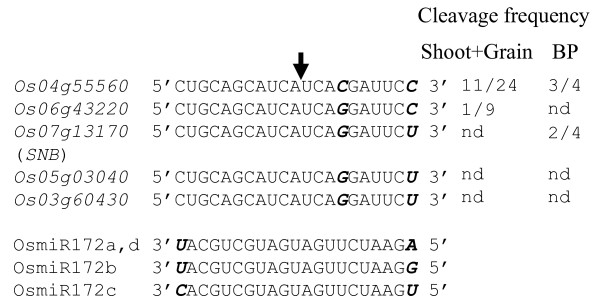
Analysis of miR172-mediated cleavage of target genes. 5' RACE was used to map the miR172-mediated cleavage sites in the predicted targets. The expected cleavage site is indicated by an arrow. Nucleotides that differ among miR172 family members or their targets are shown in bold italic. The cleavage frequencies (number of clones with the expected cleavage site/total number of clones sequenced) detected in the indicated tissues are shown to the right of the sequence alignment. BP: booting panicle. nd: no RACE product detected.